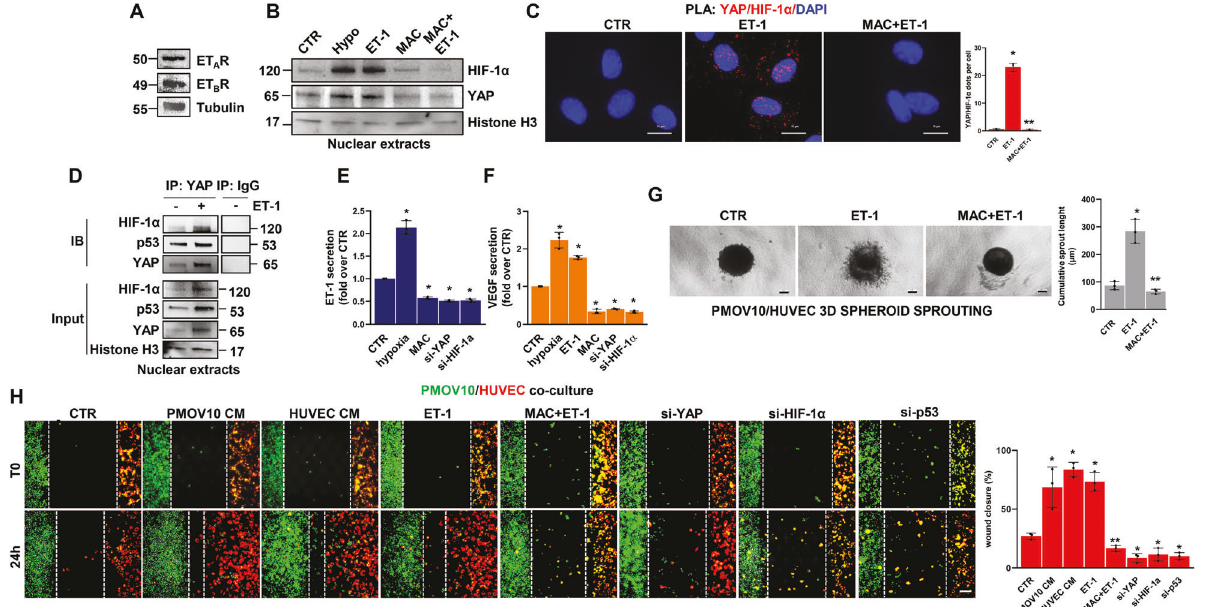
Fig. 4 The ET-1-triggered p53/YAP/HIF-1 α network enhances HG-SOC/endothelial cell cross-talk. A IB analysis of ET A R and ET B R protein expression in total HUVEC extracts. Tubulin represents the loading control. B IB analysis of YAP and HIF-1 α protein expression in nuclear extracts of HUVEC stimulated with ET-1 and/or MAC or hypoxia for 2 h. Histone H3 represents the loading control. C Representative images of PLA detection of YAP and HIF-1 α protein complexes (red signals) in HUVEC stimulated with ET-1 and/or MAC for 2 h. Nuclei are stained blue (DAPI). (Scale bar: 10 µm, magni fi cation 64X). The right graph shows the PLA quanti fi cation. Bars are means ± SD (* p < 0.0002 vs. CTR; ** p < 0.0002 vs. ET-1; n = 3). D Nuclear extracts of HUVEC stimulated with ET-1 for 2 h were IP for YAP, using anti-YAP, or anti-IgG and IB, using anti-YAP, anti-p53 and anti-HIF-1 α . Histone H3 represents the loading control. Representative images of blots of 3 independent experiments are shown. E , F ELISA for ET-1 ( E ) and VEGF ( F ) released by HUVEC silenced or not for YAP or HIF-1 α for 72 h and stimulated with ET-1 or hypoxia, or treated with MAC for 24 h. Bars are means ± SD (* p < 0.04 vs. CTR; n = 3). G Representative images of 3D hybrid PMOV10/EC spheroids sprouting into the surrounding matrix upon stimulation with exogenous ET-1 and/or MAC for 48 h (scale bar: 100 µm, magni fi cation 10X) . Right graph , quanti fi cation of cumulative sprout length (µM). Bars are means ±SD (* p < 0.002 vs. CTR; ** p < 0.002 vs. ET-1 treated cells; n = 3). H Cocultured cells with or without YAP, HIF-1 α or p53 silencing were stained green (PMOV10) and red (HUVEC) and then treated with ET-1 and/or macitentan or with PMOV10 CM or HUVEC CM for 24 h. Representative images of cells were photographed both at T0 and upon treatment for 24 h (scale bar: 100 µm, magni fi cation 20X). The right graph indicates the percentage of gap closure. Bars are means ± SD (* p < 0.02 vs. CTR; ** p < 0.0004 vs. ET-1; n =